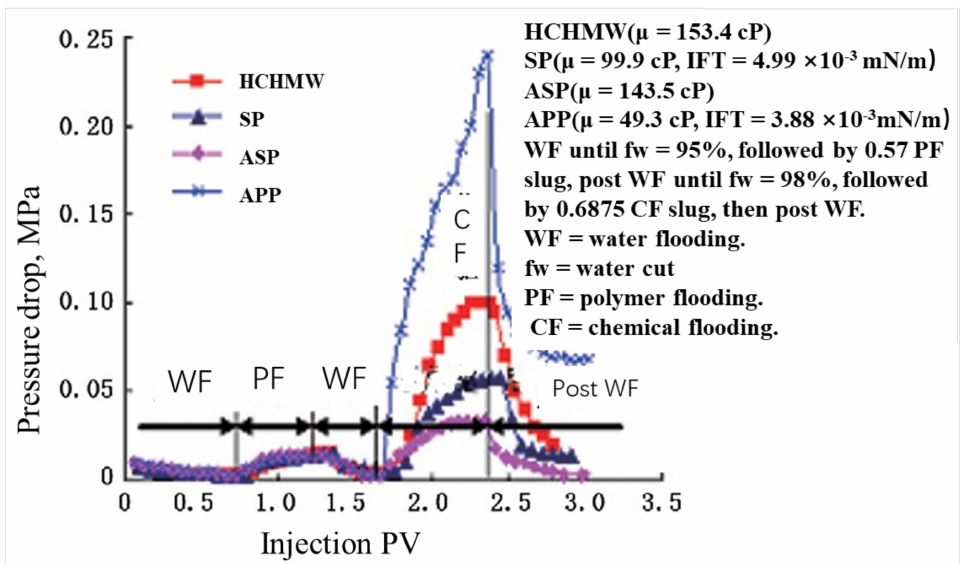
Figure 16. Injection pressure of postpolymer-flooding enhanced oil recovery techniques (revised from